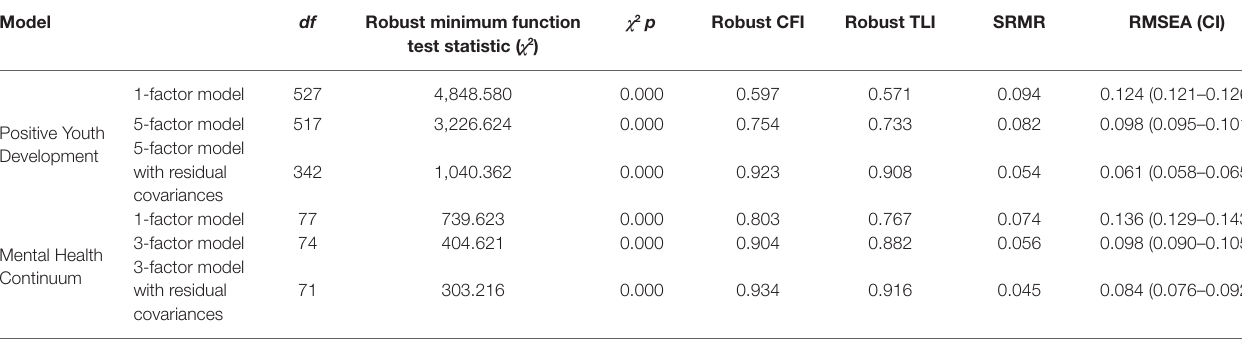
TABLE 2 | Model comparison of factor structures and psychometric properties for the study instruments. Model